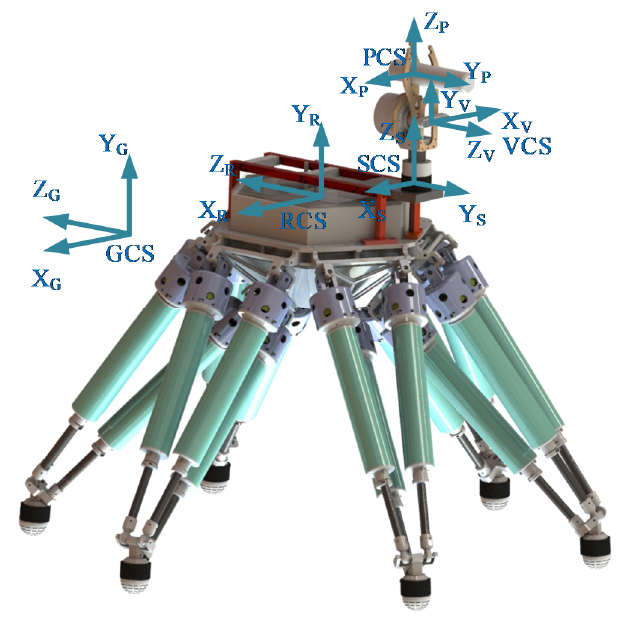
Figure 3. Definition of coordinate systems.